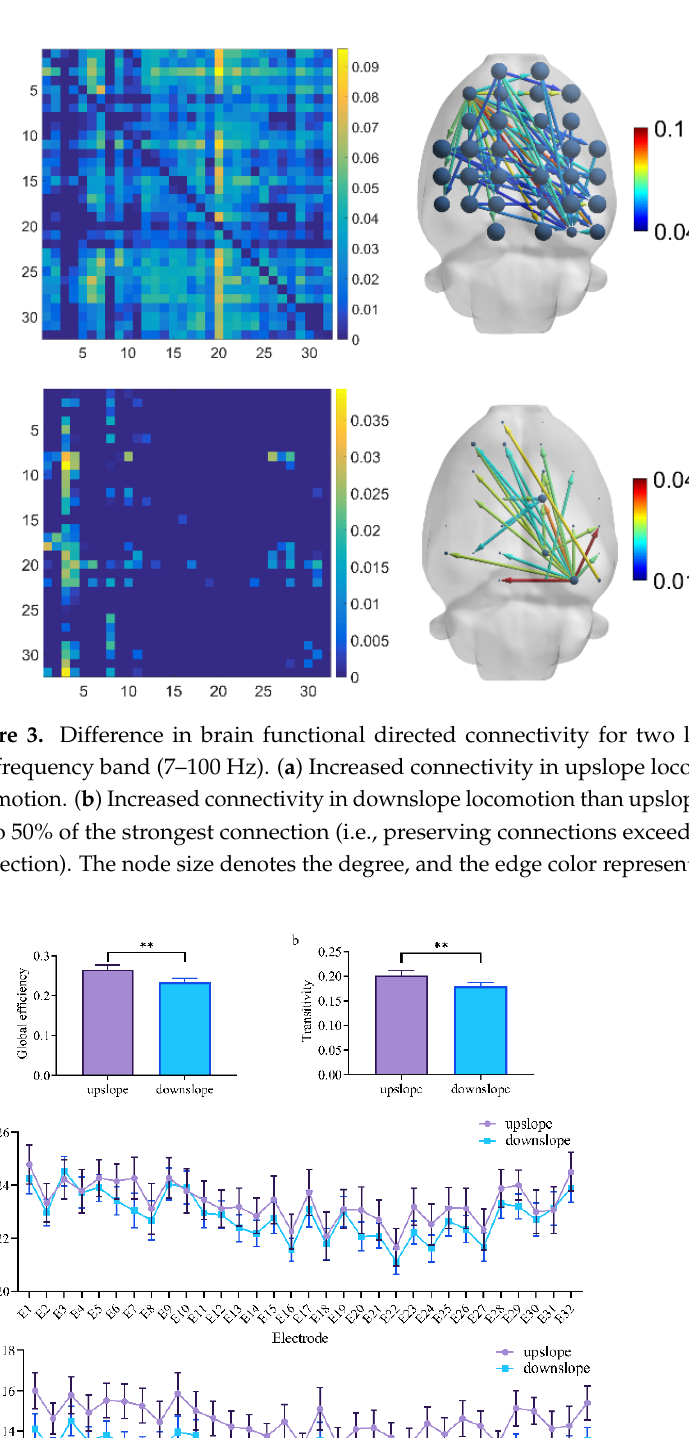
Figure 4. Indexes of the brain network for two locomotion states in the full-frequency band (7–100 Hz). ( a , b ) Global indexes of the brain network, including global efficiency and transitivity. ( c , d ) Local indexes of the brain network, including clustering coefficient and strength. All error bars indicate the 95% confidence interval of the mean. ** p ≤ 0.01. 3.2. Brain Functional Directed Connectivity in Rats Presented a Significant Difference in Each Sub-Band We next explored the difference in brain functional directed connectivity in four ma- jor sub-bands—the alpha band (7–13 Hz), beta band (13–30 Hz), low gamma band (30–50